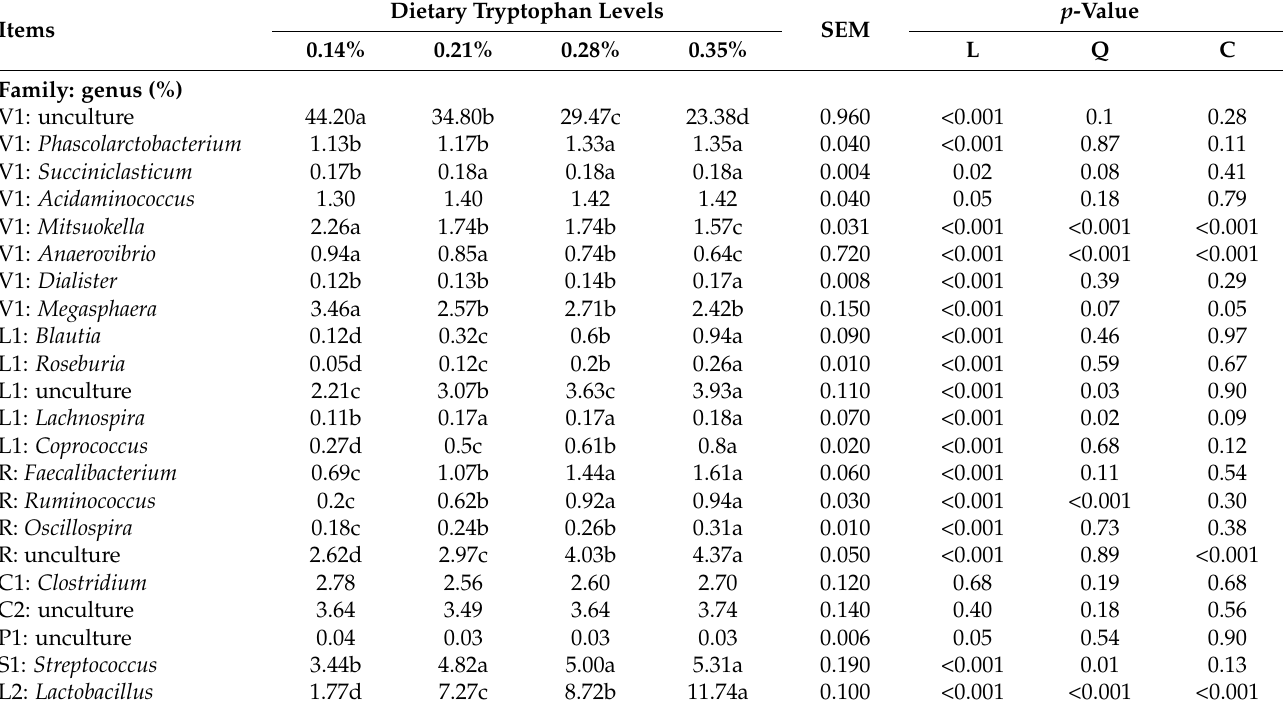
Table 9. Effect of dietary tryptophan levels on the microbial composition in the caecum of weaned piglets at the genus